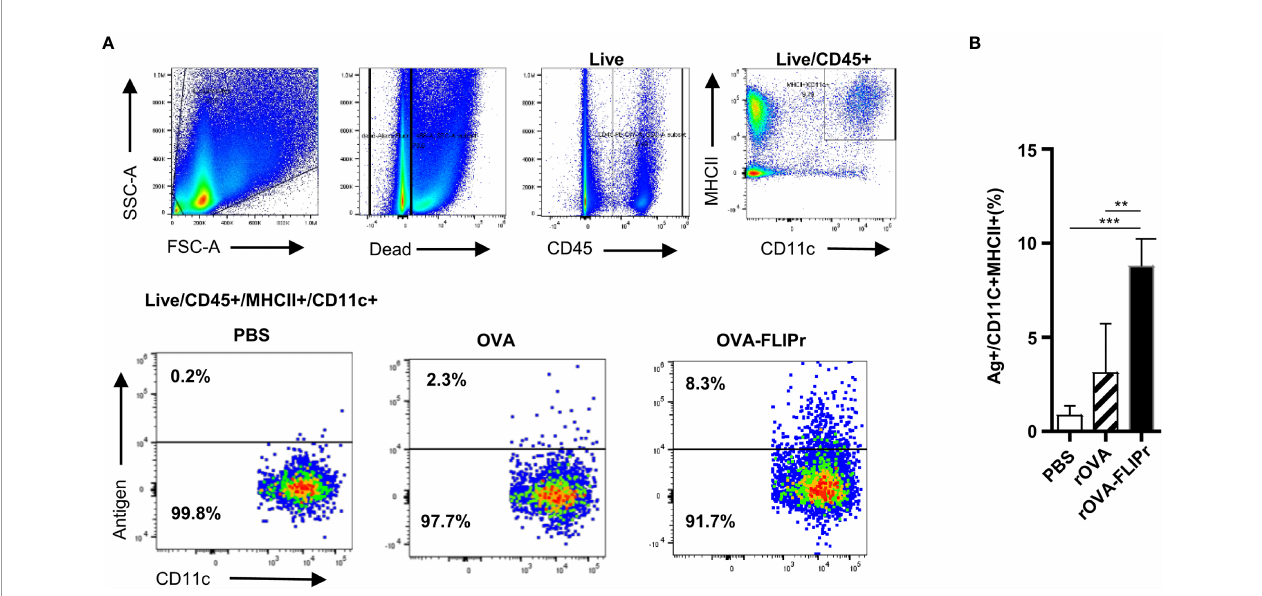
FIGURE 2 | Ovalbumin fusion with FLIPr ef fi ciently delivers to NALT dendritic cells via intranasal administration. (A) Gating strategy for the dendritic cell population in NALT. A group of C57BL/6 mice was intranasally administered 30 m g Alexa Fluor 647-labeled OVA or OVA-FLIPr. Mice administered PBS were used as control. Cells were harvested 2hours after administration. A single-cell suspension of nasal cells (pooled from 3 mice) was obtained by mechanical disruption and collagenase digestion of nasal tissue. Dead cells were excluded from analysis by staining with a Live/Dead ® fi xable dead cell stain dye. DCs from the NALT gated on live/CD45 + /CD11c + MHCII + cells. (B) The frequencies of antigen-labeled CD11c + MHC II + cells. Cumulative data from three individual experiments are quanti fi ed here. The data are presented as the mean ± SEM (n = 3). Statistical signi fi cance was determined using the Kruskal-Wallis test with Dunn ’ s multiple comparison test. **p<0.01; ***